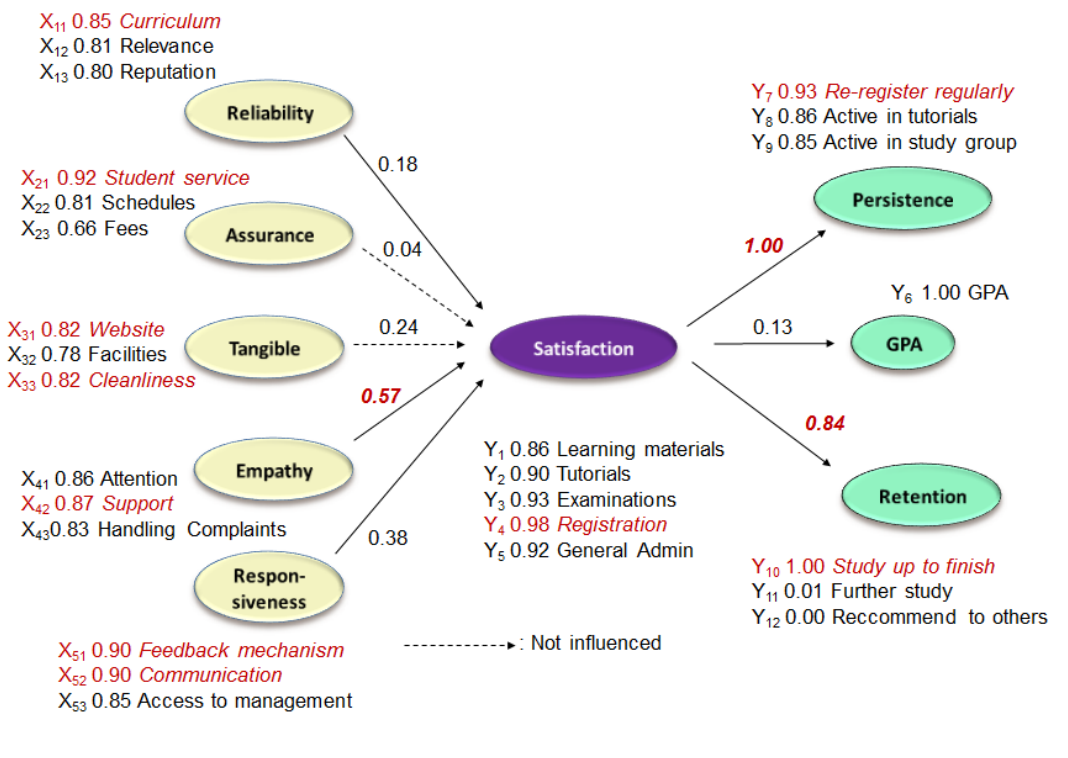
Figure 4 Loading factors of the